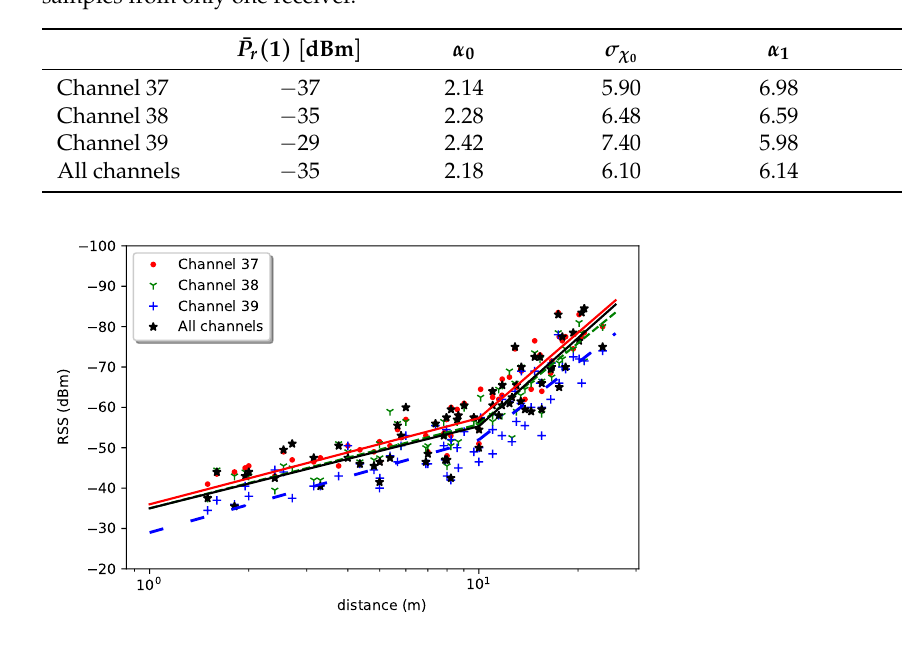
Figure 16. Two-segment path loss models derived using the median of one random data sample from each of the six receivers. Table 3. Two-segment path loss model parameter values derived using the median of one random data sample from each of the six